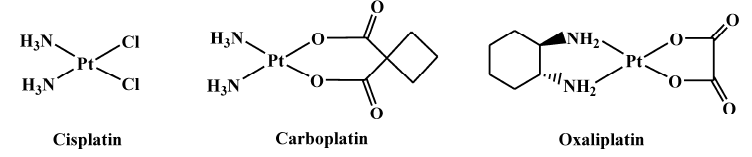
Figure 1. Pt(II) complexes worldwide clinically used.